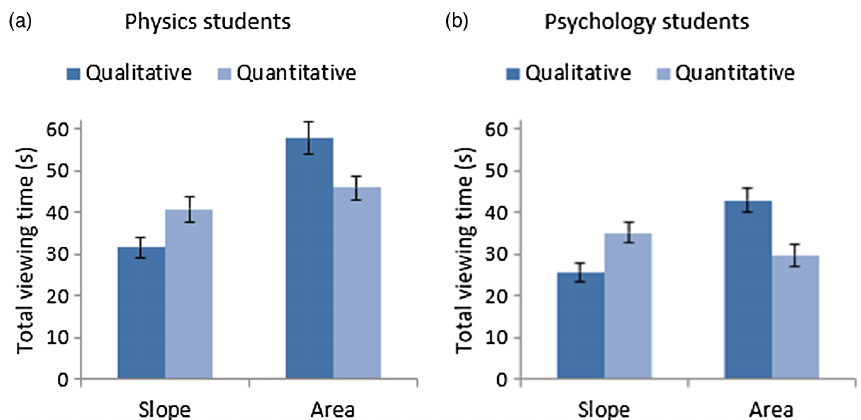
FIG. 4. (a) Average total viewing time of physics students on the qualitative and quantitative questions about graph slope and area under a graph. (b) Average total viewing time of psychology students on the qualitative and quantitative questions about graph slope and area under a graph. The error bars represent 1